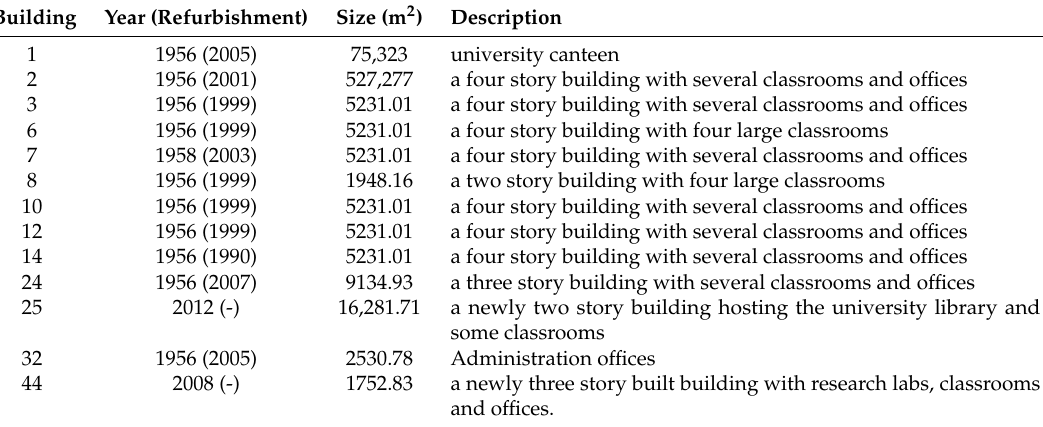
Table 1. Description of the selected buildings. The first column presents the year of construction and the year of the refurbishment if was made. The second column present the size in m 2 , and finally a short description.